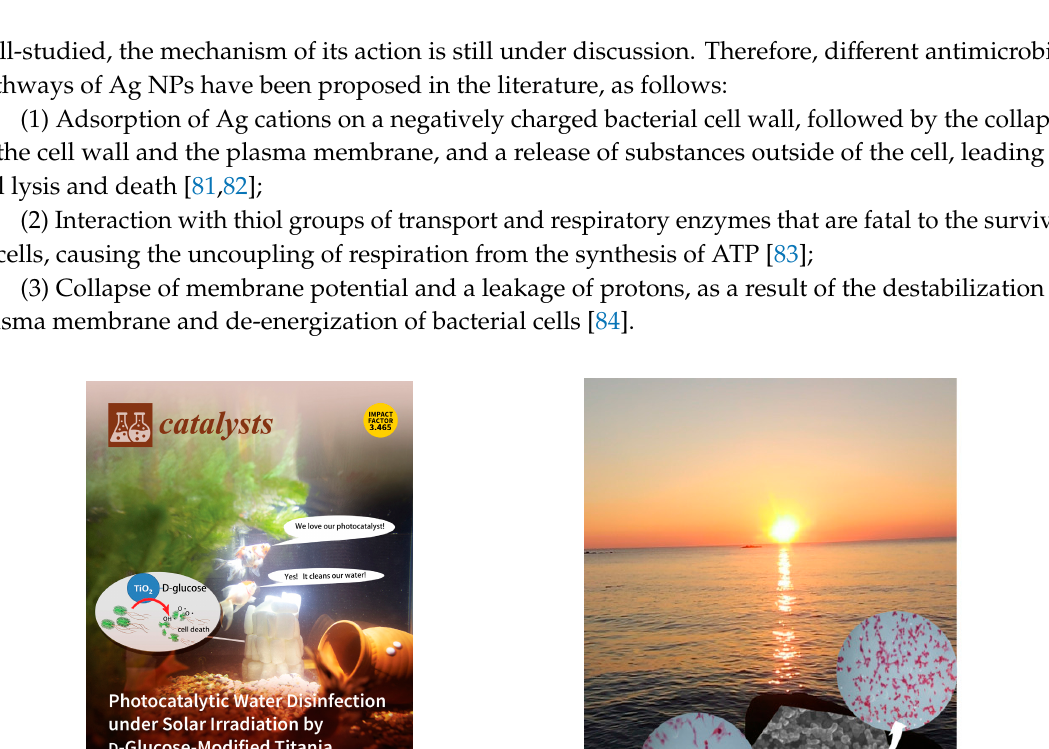
Figure 1. Images of three ‐ day growth of Aspergillus melleus : ( a ) in the dark and ( b ) under irradiation in the presence of commercial titania photocatalyst P25 (after homogenization); adapted with permission (after formatting) from [79]. Copyright (2015) Elsevier.